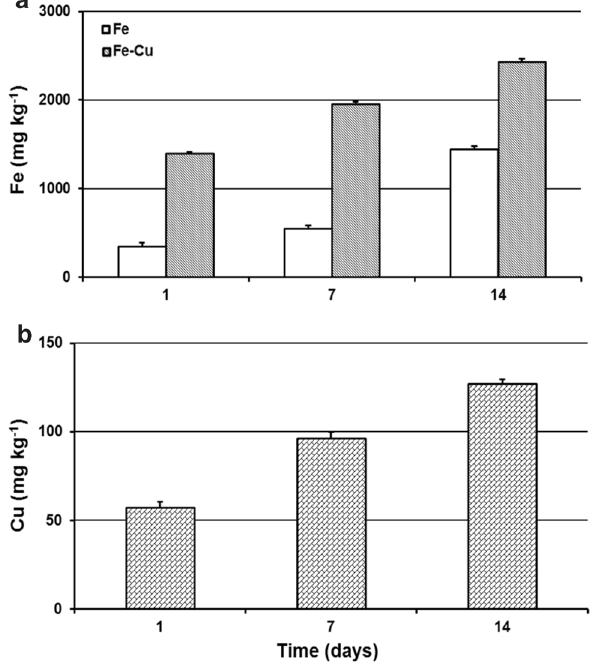
Fig. 3 Accumulation of ( a ) iron and ( b ) copper in T. latifolia of the two microcosms (Fe and Fe–Cu). Error bars represent SD ( n =